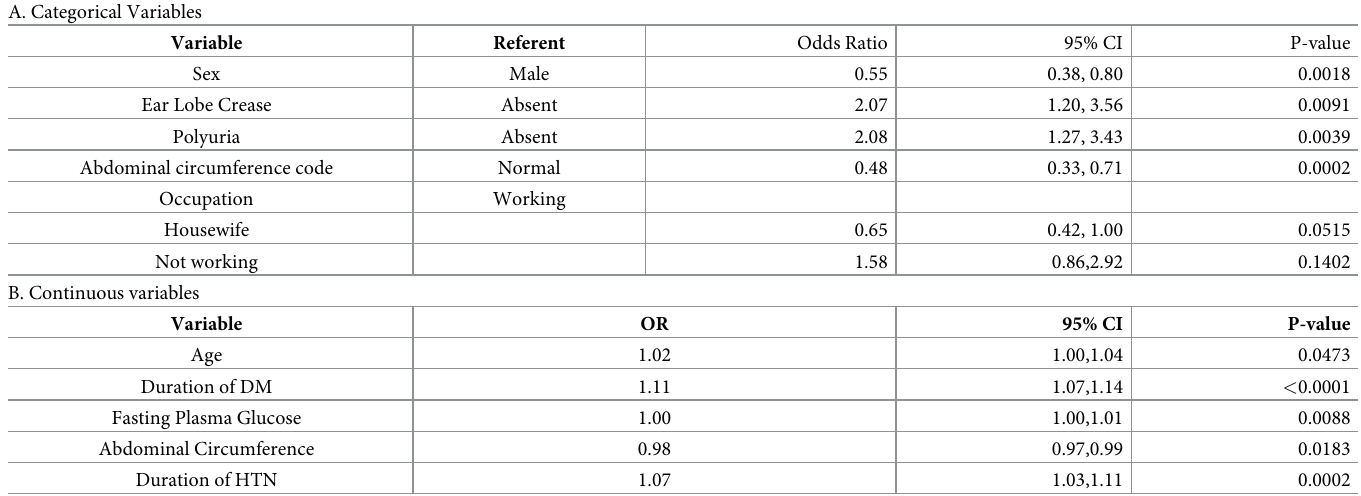
Table 7. Univariate association with DR among those with a hypertension diagnosis (n = 609). A. Categorical Variables